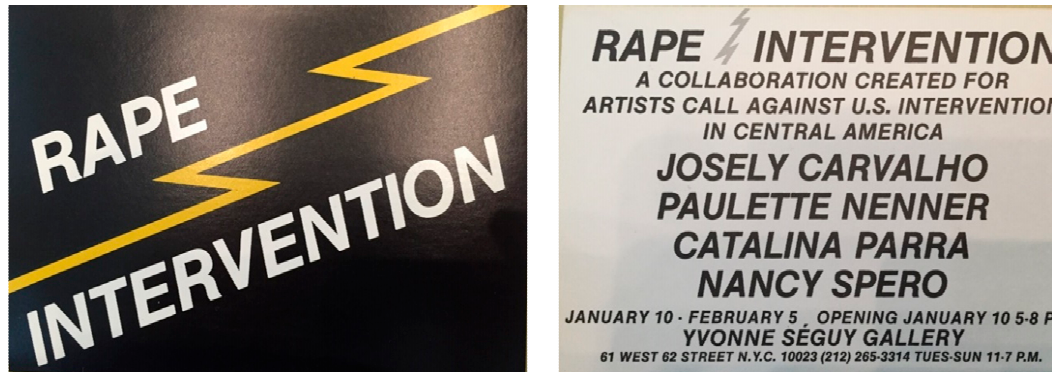
Figure 10. Rape/Intervention , Yvonne Séguy Gallery, postcard announcement for Artists Call Against U.S. Intervention in Central America, 1984. Artists Call Against US Intervention in Central America, miscellaneous uncatalogued material, MoMA Library, used by permission.